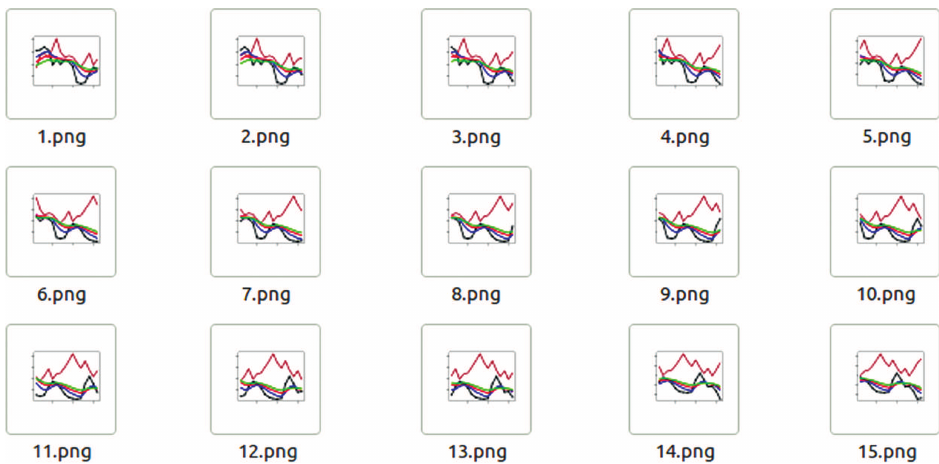
Figure 33: Experiment 3 using Open, Close, MA5, MA10, and MA20 with Label 1.